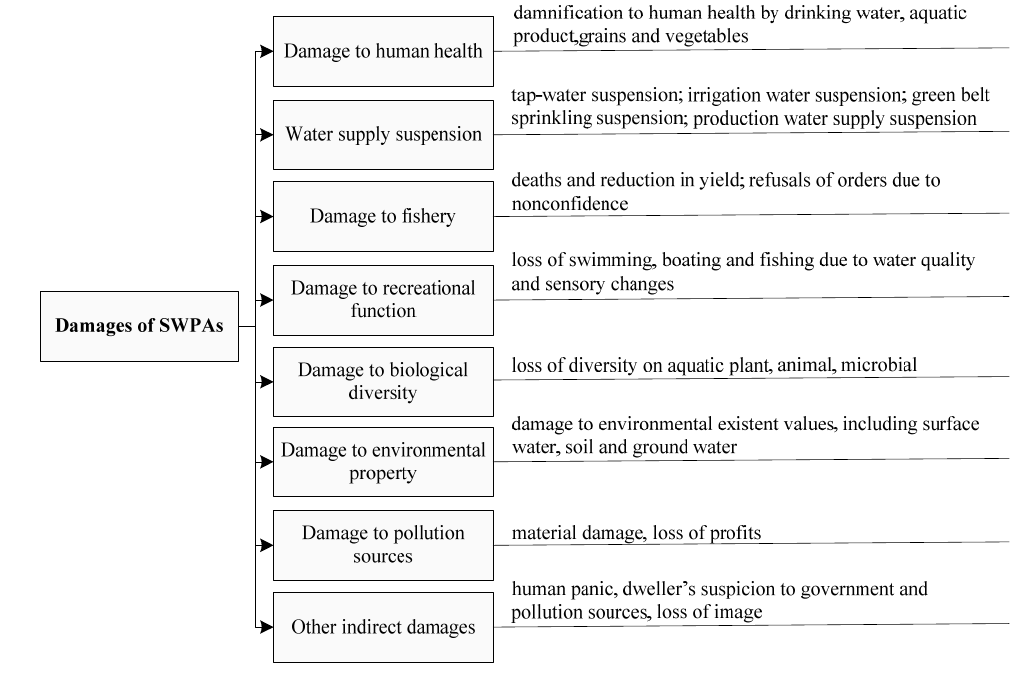
Figure 1. Potential damages caused by SWPAs.